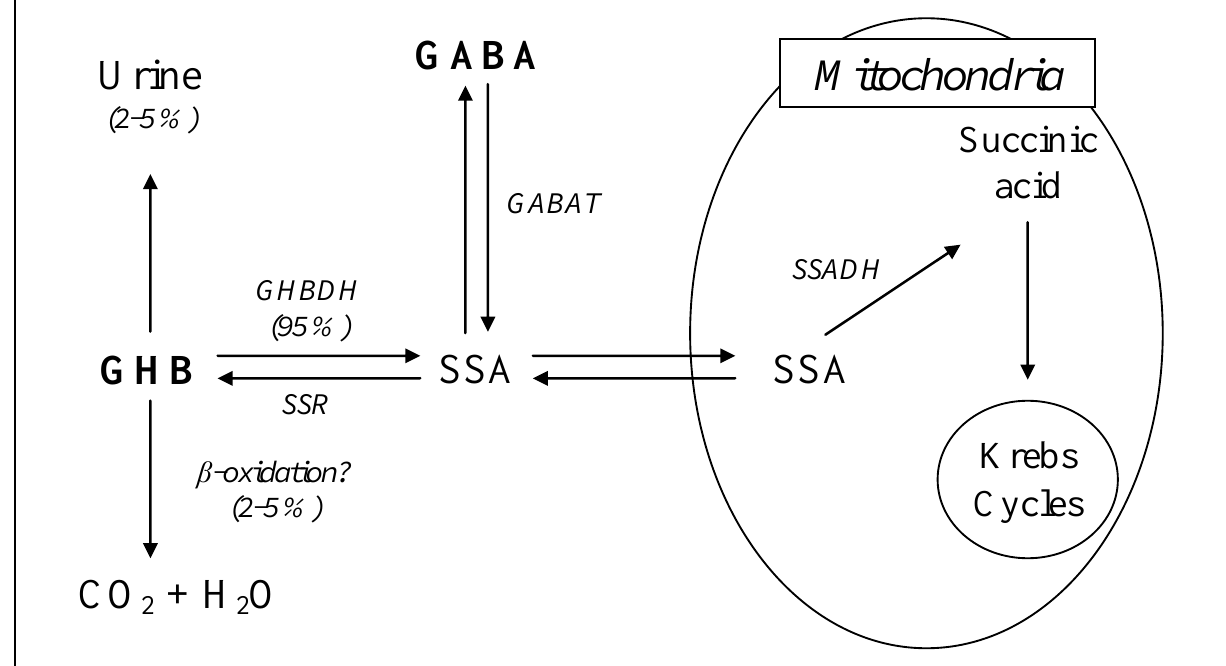
Figure 1. GHB metabolism in the central nervous